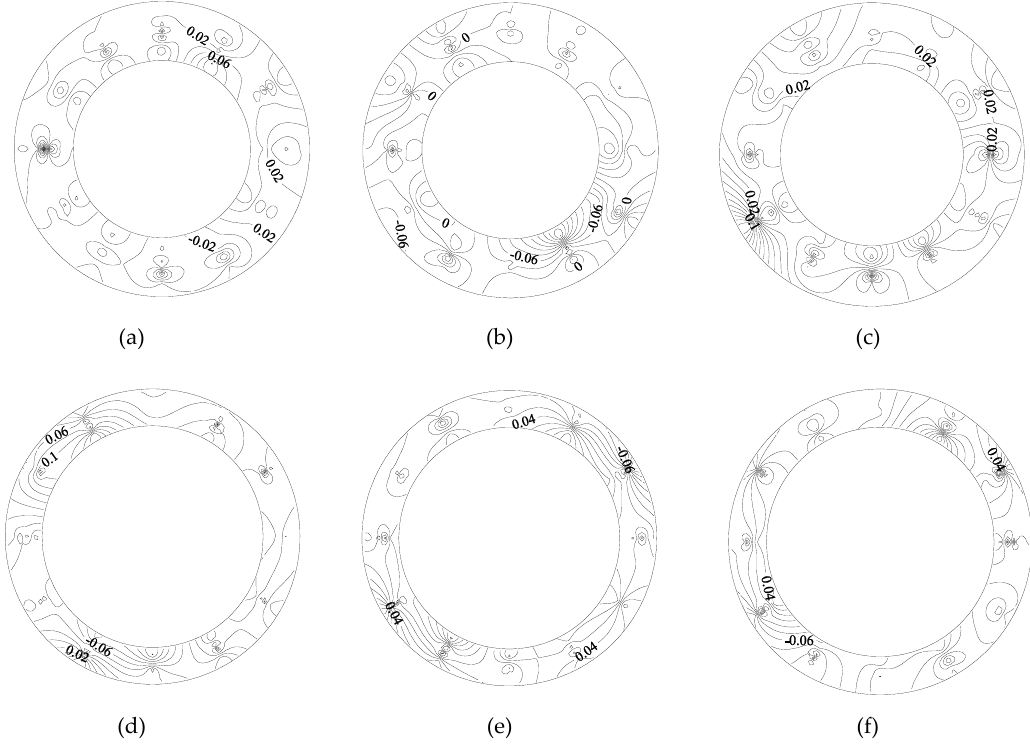
Figure14. Circumferentialflowvelocitydistributionofannulargapsectionsofthecapsules: ( a ) L / d = 2.5, rear section; ( b ) L / d = 2.5, middle section; ( c ) L / d = 2.5, front section; ( d ) L / d = 2.14, rear section; ( e ) L / d = 2.14, middle section; and ( f ) L / d = 2.14, front